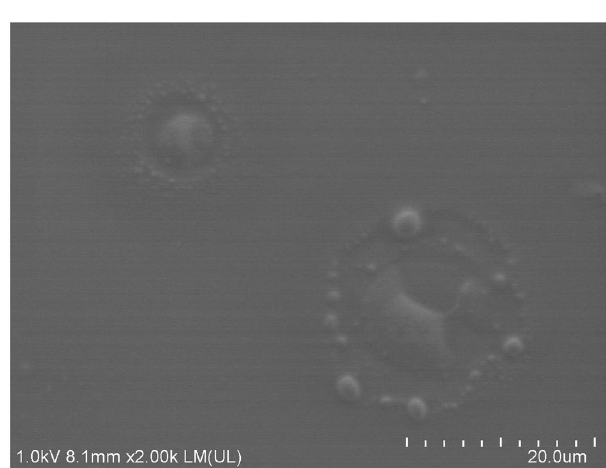
Figure 6. The SEM (Scanning Electron Microscope) image of the